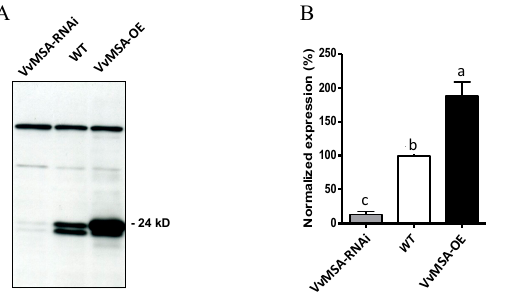
Figure 2. Western blot analysis of the VvMSA expression in WT, VvMSA-OE and VvMSA-RNAi cell suspensions. ( A ) Immune detection of VvMSA proteins separated by SDS-PAGE of 20 µg total protein extract of each of the cell suspensions and transferred onto nitrocellulose membrane. The prominent higher MW non-specific bands with even intensity, that are immunorevealed by the polyclonal anti-VvMSA antibody, serve as a loading control. ( B ) Signal quantitation using ImageJ, v.1.4. The VvMSA expression of the transgenic lines is presented as a percentage of that of the WT (considered as 100%). The histograms show the mean of three independent experiments. The letters denote the groups that were found significantly different by ANOVA and Fisher LSD test ( p <